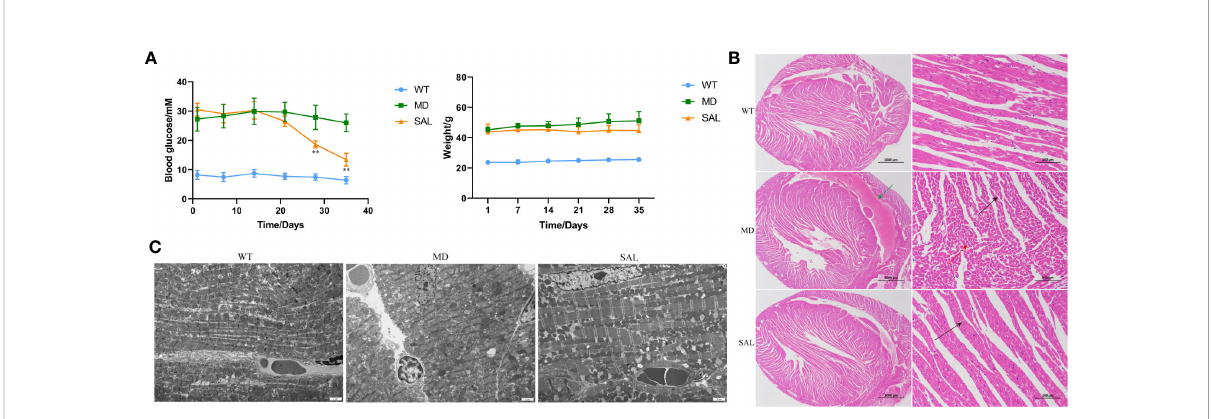
FIGURE 1 In fl uence of SAL on glucose regulation and diabetic cardiomyopathy in diabetic mice. (A) , Changes in the blood glucose and weight of db/db mice during the period of SAL treatment. (** p < 0.05 as MD group vs SAL group). (B) , H&E staining of myocardial tissue sections. (C) , Transmission electron microscopy of myocardial cells.Green arrow: extravasation of the heart cavity; black arrow: irregularly shaped cavities; red arrow: necrotic cardiomyocytes.